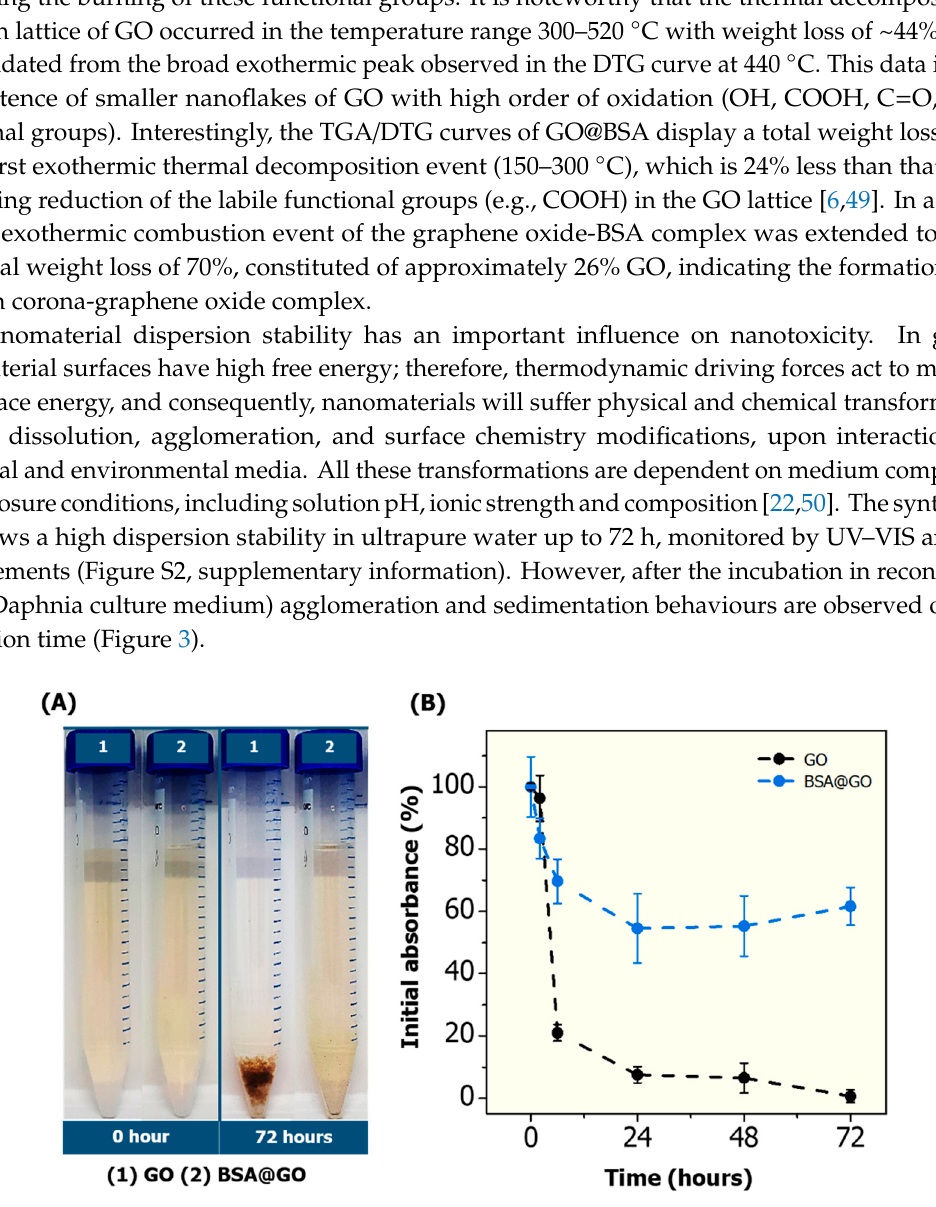
Figure 3. Dispersion stability of GO and BSA@GO materials (10 mg L − 1 ) in reconstituted water from 0 to 72 h at 20 °C: ( A ) Digital picture for visual inspection; and ( B ) Percentage of material in suspension relative to initial absorbance (at 400 nm).